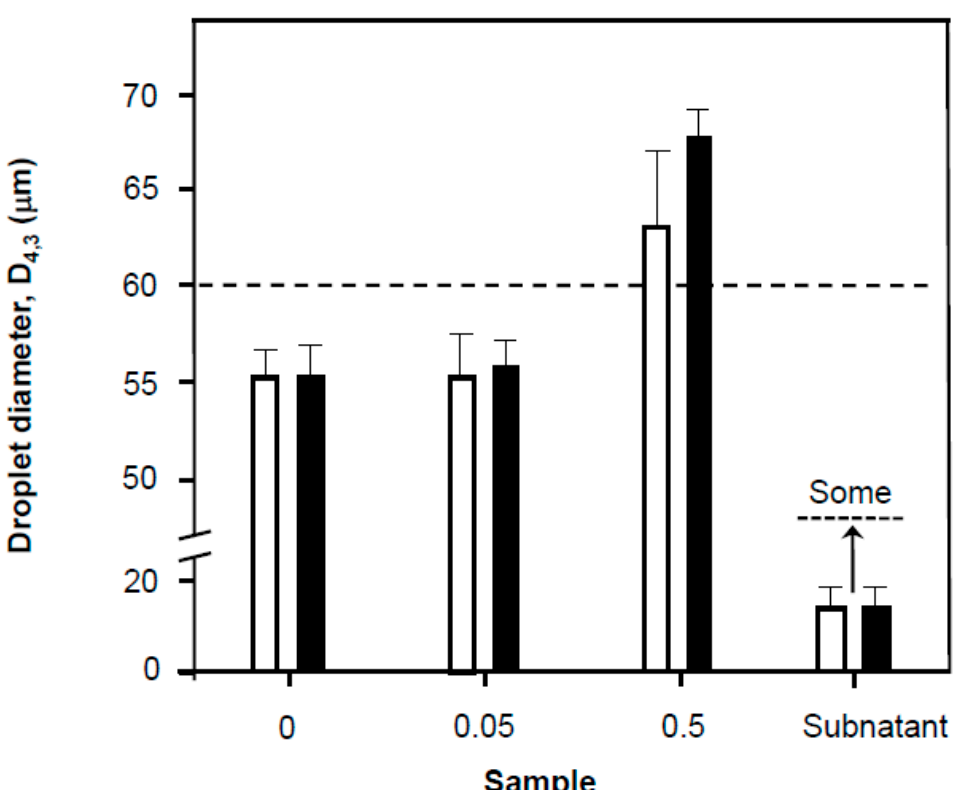
Figure 8. Emulsion droplet size for the test system using 1 mM Tween 80 and 0.65 mM betamethasone 21-phosphate as a function of carbopol inclusion in the aqueous phase at 20 °C also in the presence of 1 × 10 − 5 M sodium azide. The values presented as 0, 0.05 and 0.5 refer to the concentration of included carbopol (% w / v ). The polymer samples were carbopol 971P (unfilled bars) and carbopol 974P (filled bars). The particle size in subnatant aqueous portions of the emulsions formed (control-Tween only and in the presence of carbopol polymers were numerically indistinguishable) are also presented. The broken horizontal line is included to emphasize the difference in droplet diameter at dilute and concentrated carbopol inclusion. All solutions used for samples were prepared from surface chemically pure 50 mM sodium phosphate buffered water, pH 7.0.